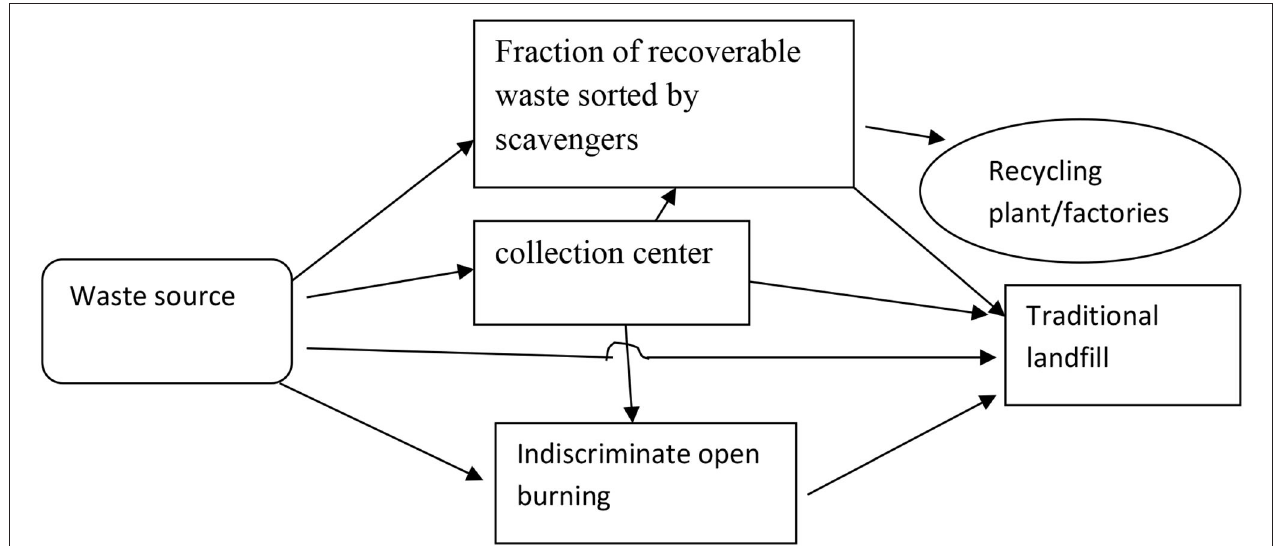
FIGURE 3 | The Schematic diagram of the solid waste flow of current SWM practice in Kano metropolitan. Source: Accord-Cadre Ville et Changement Climatique en Afrique Sub-Saharienne (CICLIA), Client Project Reference: AFD/DOE/EBC/CLD | ACH-2017-026 Internal project reference: A17FDD029 (2018)